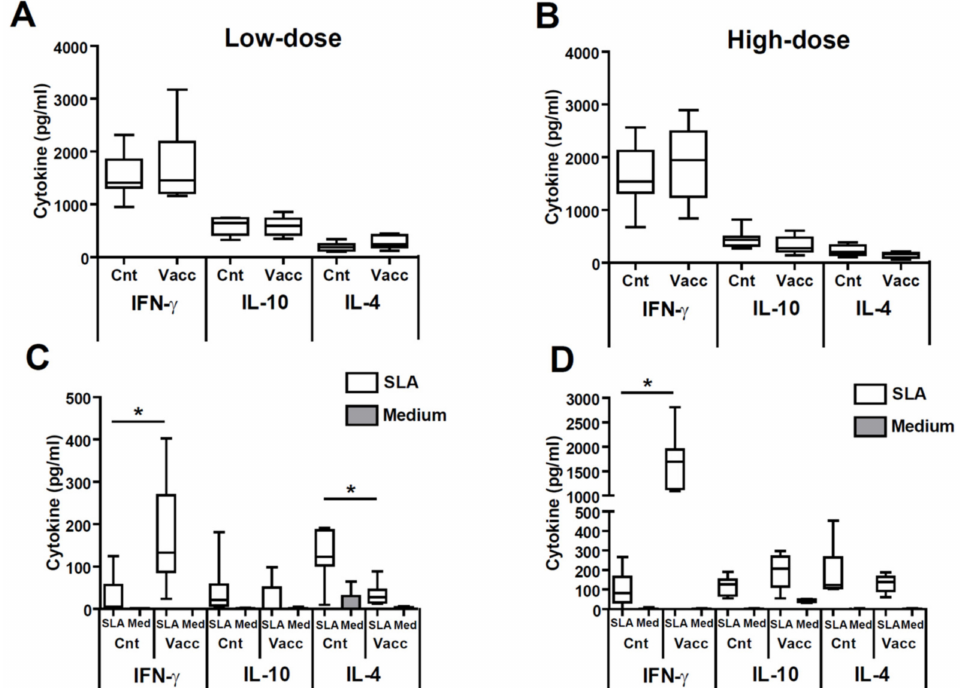
Figure 3. Analyses of the systemic production of cytokines. BALB/c mice were inoculated with PBS (control) or with 1 × 10 7 Li ∆ HSP70-II attenuated promastigotes suspended in PBS (vaccinated) in the right footpad. At week 12 after vaccination control and vaccinated mice were challenged with 5 × 10 4 (( A , C ); low dose, n = 5) or 5 × 10 6 (( B , D ); high dose, n = 8) stationary L. amazonensis promastigotes in the left footpad. Animals were sacrificed at week 11 (high dose) or week 14 (low dose) post-challenge and their spleen cells were independently cultured in the presence of ConA (1 µ g/mL; ( A , B )), L. amazonensis SLA (12 µ g/mL) or in medium alone ( C , D ). The levels of IFN- γ , IL-10, and IL-4 were assessed by ELISA in culture supernatants and are shown as whisker (min to max) plots. * ( p < 0.05) shows the statistical differences between control and vaccinated groups (Mann–Whitney test). Results from one out of two similar experiments are